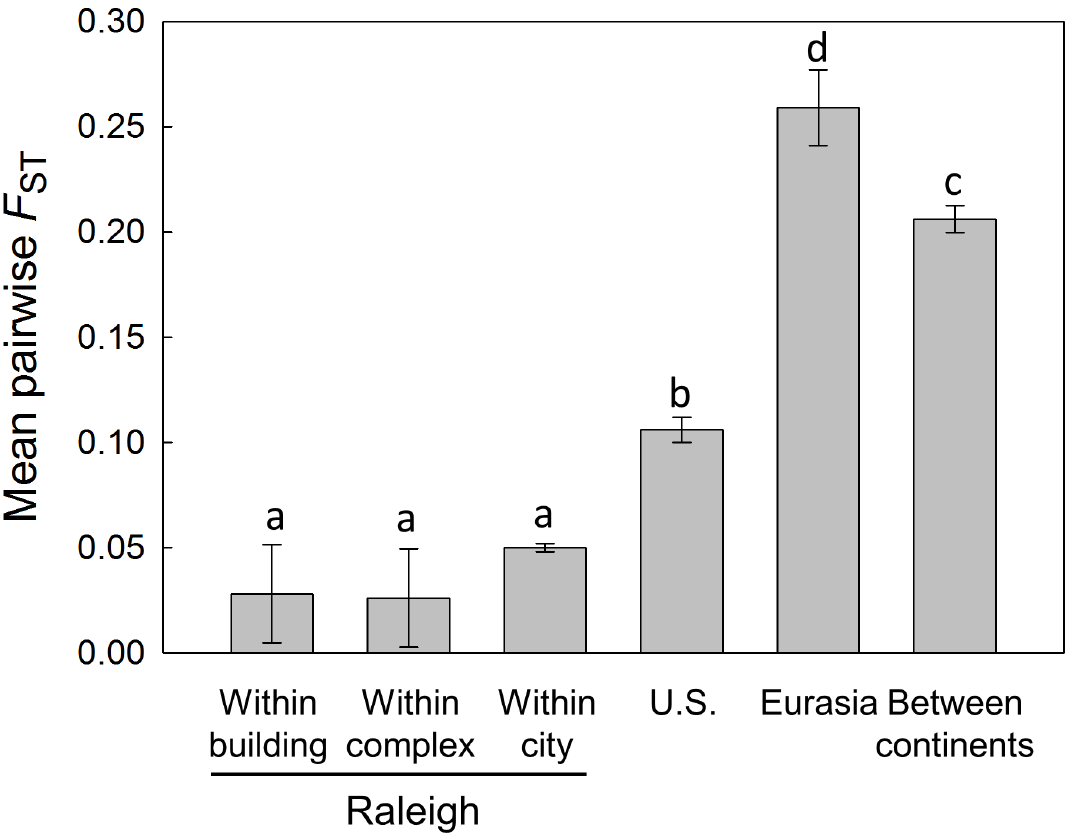
Figure 1. Levels of genetic differentiation among B.germanica populations at different spatial scales. Shown are mean pairwise F ST values ( 6 SE) for all pairs of populations at each level of analysis. The value for the U.S. consists of comparisons between cities in the continental U.S. (i.e., excluding Hawaii and Puerto Rico), including comparisons between Raleigh and other cities but excluding comparisons between apartments within Raleigh represented by only sample location DR-X. The value for ‘‘between continents’’ consists of all comparisons between populations in North America and populations in Eurasia. Bars labeled with different letters are significantly different ( P , 0.05).